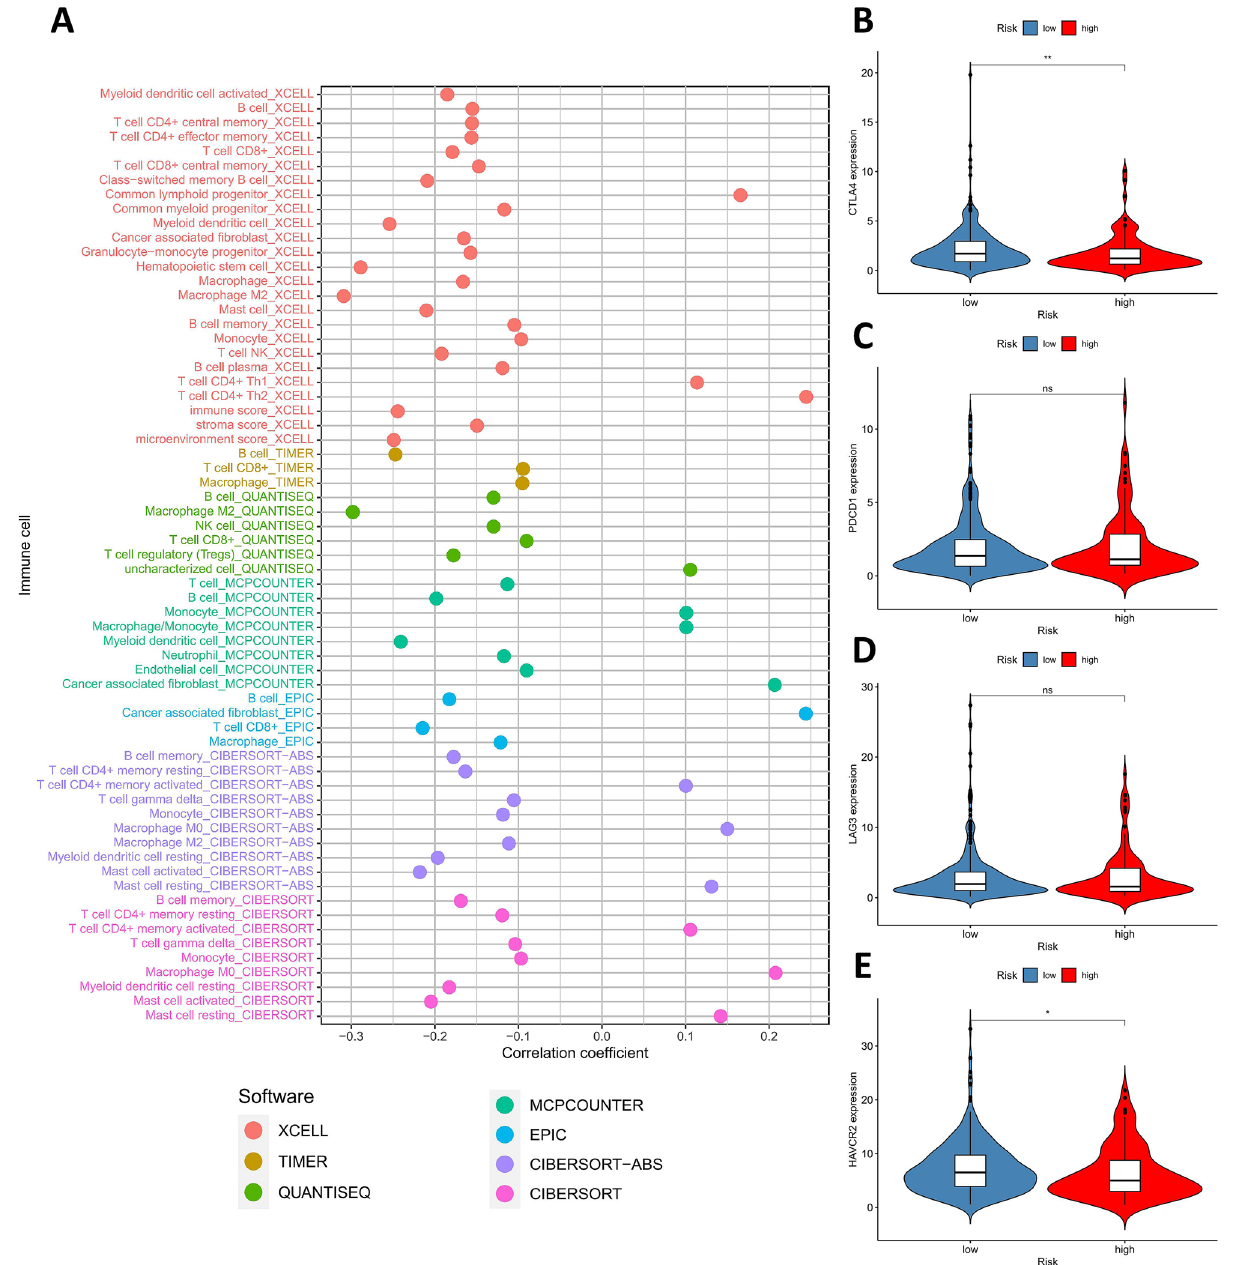
Figure 4. The immune significance of the risk model in LUAD. ( A ) The correlation between risk score and tumor-infiltrating immune cells, which were analyzed by seven different quantification methods of immune infiltration estimations including TIMER, xCell, quanTIseq, MCP-counter, EPIC, CIBERSORT-ABS, and CIBERSORT. ( B-E ) The relationship between risk model and the expression levels of immune-related molecules, including CTLA4 ( B ), PDCD1 ( C ), LAG3 ( D ), and HAVCR2 ( E ). LUAD, lung adenocarcinoma; CTLA4 , cytotoxic T-lymphocyte associated protein 4; PDCD1 , programmed cell death 1; LAG3 , lymphocyte activating 3; HAVCR2 , hepatitis A virus cellular receptor